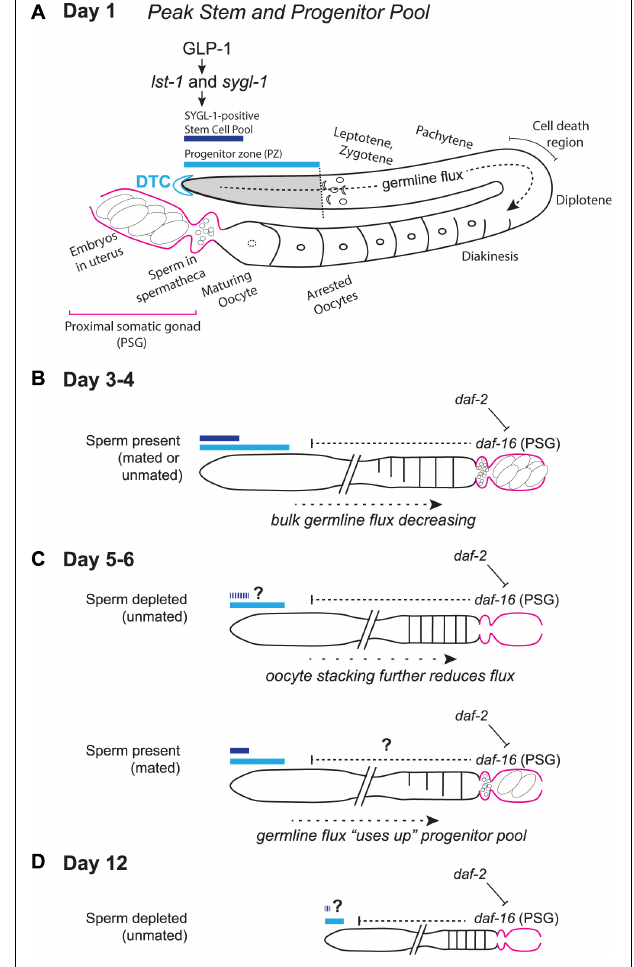
FIGURE 1 | Schematic representation of the aging C. elegans adult hermaphrodite reproductive system. (A) Early adult gonad anatomy. The germline progenitor zone is located at the distal end of the gonad. As progenitors proliferate, they are displaced and move proximally (“germline flux”), progressing through oogenic prophase of meiosis I until they become arrested in diakinesis at the proximal end of the oviduct, awaiting maturation-inducing signals from sperm in the spermatheca. (B) Simplified schematic of a days 3–4 adult gonad, depicting distal stem/progenitor pool and proximal arrested oocytes, sperm in the spermatheca and embryos in the uterus. (C) Schematics representing aged (days 5–6) sperm-depleted and sperm-replete conditions. (D) Schematic representing a post-reproductive day 12 gonad. Regardless of sperm availability, reproduction has ceased, and the progenitor zone is severely reduced. Diagrams in (A–D) represent wild-type worms. Additional notes: The progenitor zone of aged hermaphrodites contains fewer cells than at adult day 1 peak; in mated hermaphrodites (as yet untested in the other conditions) SYGL-1- and LST-1- positive pools also decline. Sperm-depleted hermaphrodites accumulate unfertilized oocytes in the oviduct, whereas sperm-replete hermaphrodites do not. The PZ mitotic cell cycle also slows, as does the rate of meiotic entry and the rate of progression through prophase of meiosis I. These age-related changes in bulk germline flux contribute to the reduction in progeny production with age. The numbers of oocytes are schematized here to emphasize flux vs. stacking; Kocsisova et al. (2019) report an average of ∼ 14 oocytes are in diplotene and diakinesis at days 1 and 3 and an average of ∼ 9 at day 5 in mated hermaphrodites. See text for details and additional